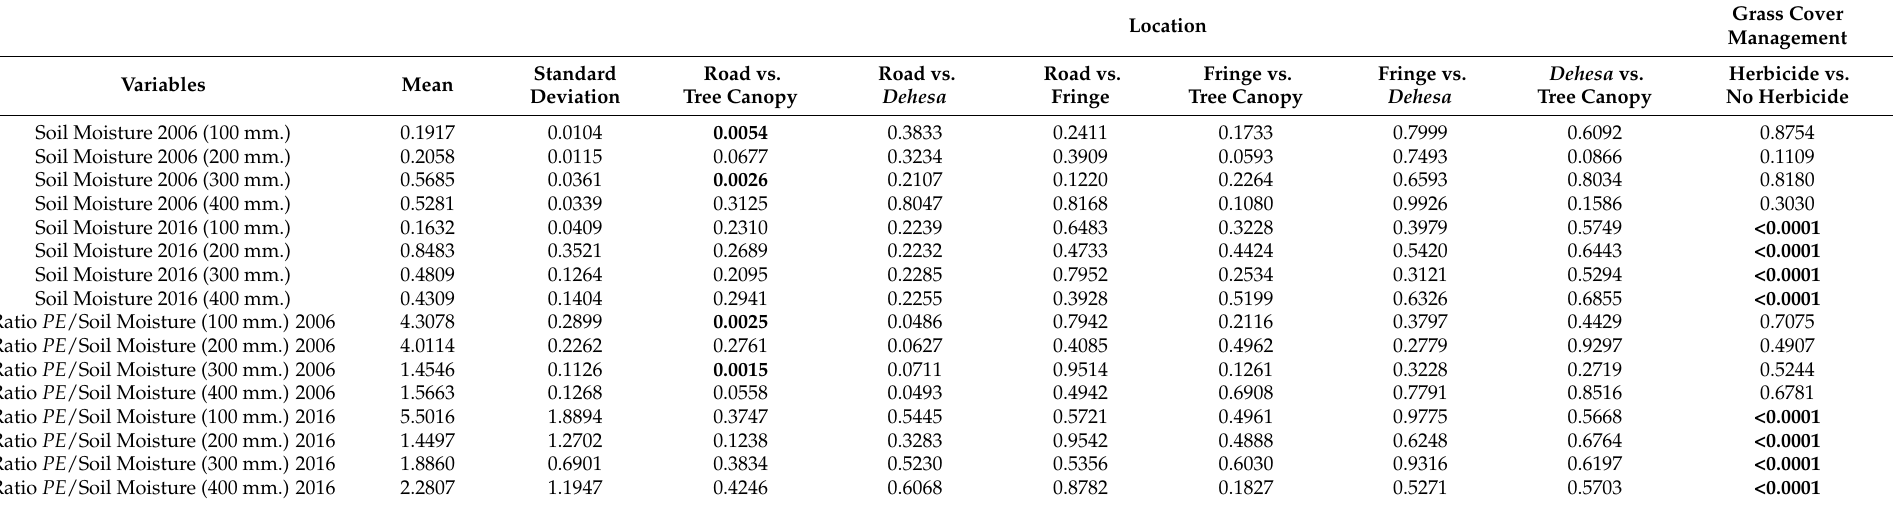
Grass Cover Location Management Dehesa vs. Standard Road vs. Road vs. Road vs. Fringe vs. Fringe vs. Herbicide vs. Dehesa Dehesa Deviation Tree Canopy Fringe Tree Canopy Tree Canopy No Herbicide